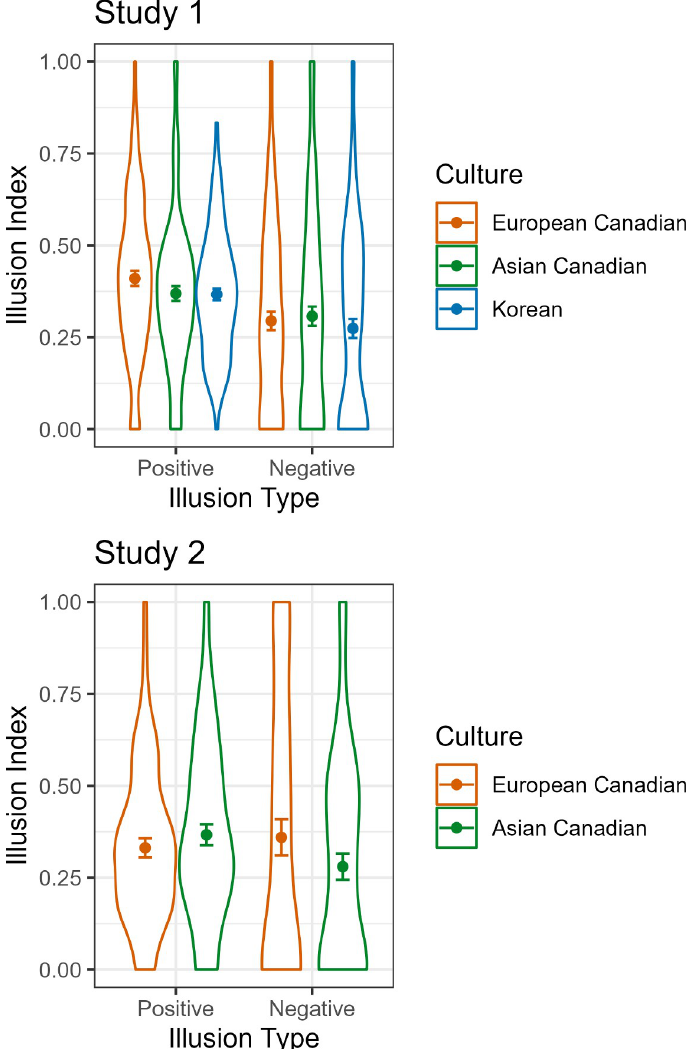
Fig 2. Positive and negative illusion indices. The point estimate and error bars represent the mean and standard error of the mean, respectively. The violin plot represents the distribution of the